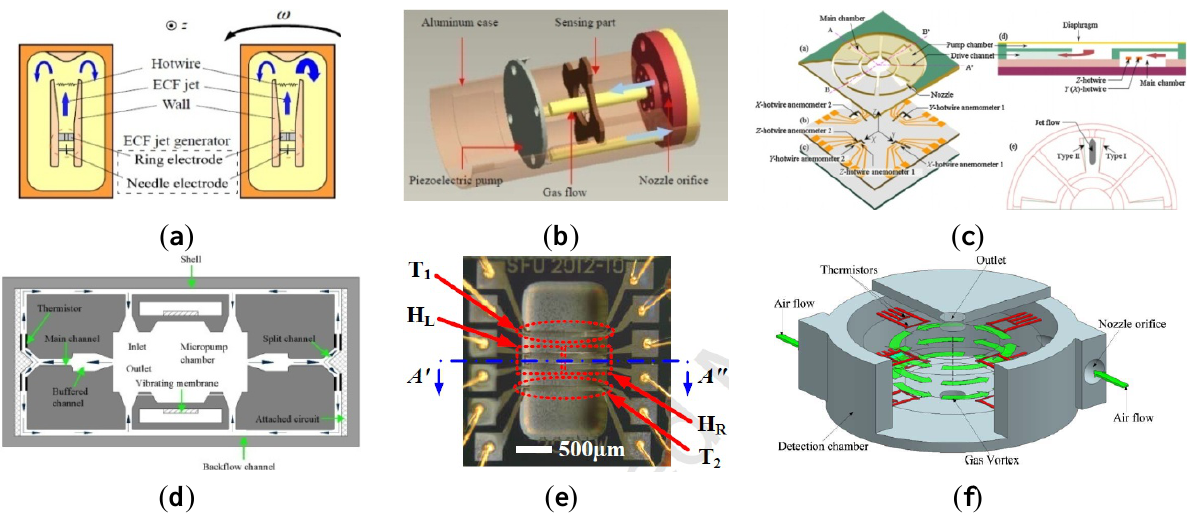
Figure 21. Various micro fluid gyroscopes. ( a ) Keio University gyroscope. ( b ) TSCL and RU gyroscope. ( c ) RU gyroscope. ( d ) HUST gyroscope. ( e ) Jamal Bahari gyroscope. ( f ) Northwestern Polytechnical University (NPU)